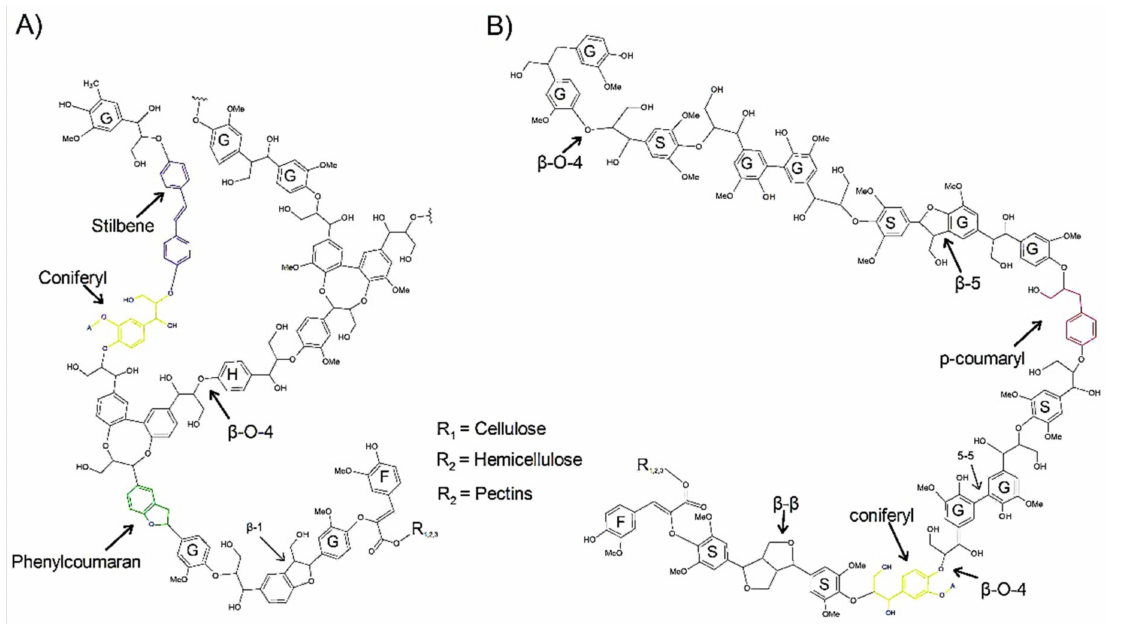
Figure 1. Molecular structure of lignin. ( A ) G-type lignin with the presence of fluorophores. ( B ) S-type lignin with the presence of fluorophores. F, ferulates; H, p -hydroxyphenyl; G, guaiacyl; S,